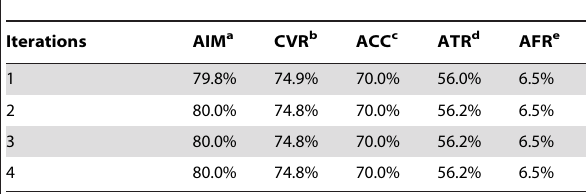
Table 3. Performances of iterative prediction.